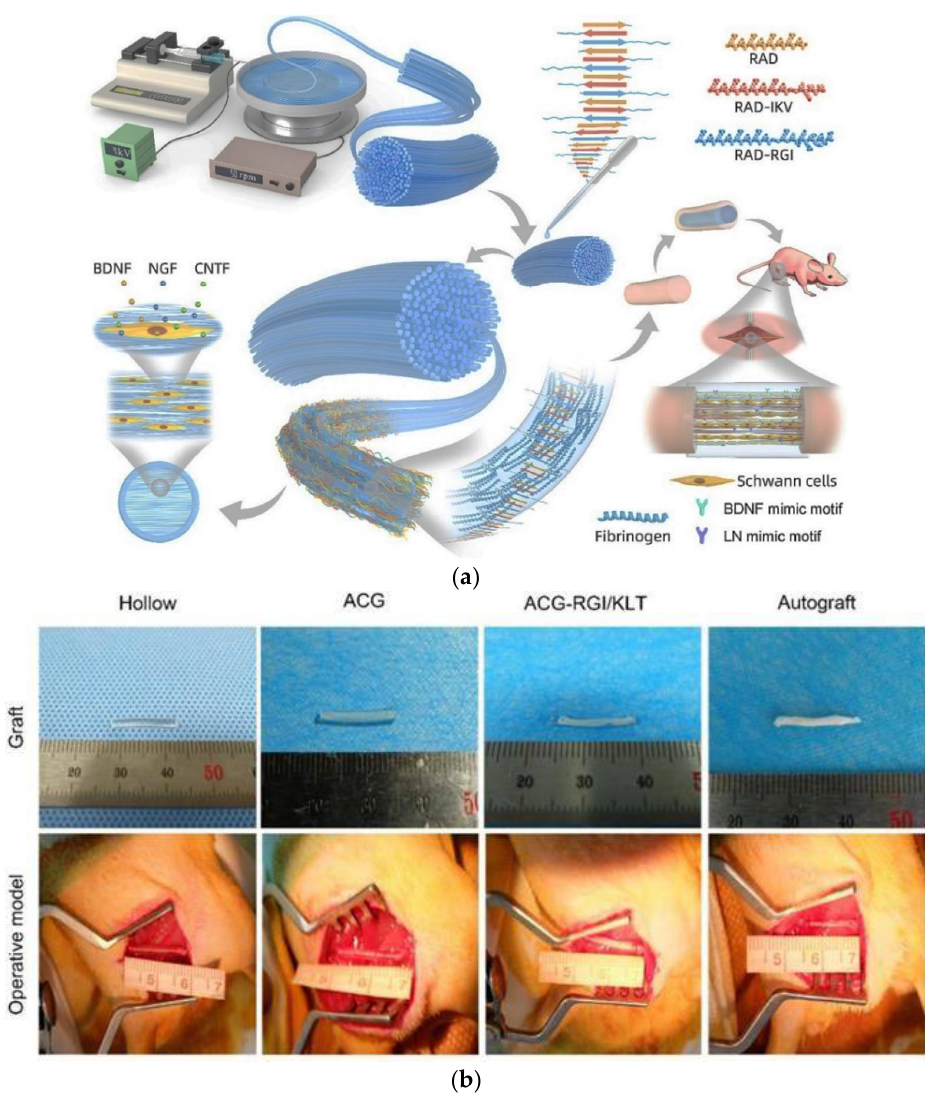
Figure 5. ( a ) Schematic diagram of the fabrication of AFG/fSAP interpenetrating hydrogel and the in vitro and in vivo evaluations (reproduced from [85] with permission of Elsevier, 2021), and ( b ) Gross view of nerve grafts and operative model of all groups. The chitin conduits were light yellow in color and transparent. ACG and ACG-RGI/KLT were white, similar to sciatic nerves. All groups received the 15-mm sciatic nerve defect (reproduced from [87] with permission of KeAi Publishing, 2020).